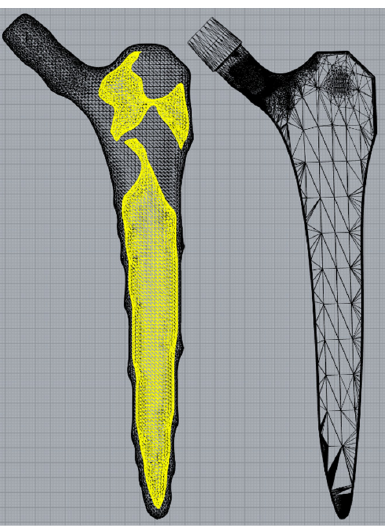
Figure 2. Tapered protrusions (left) enabled a gradual transition between the porous and solid re- gions of the porous implant (right).